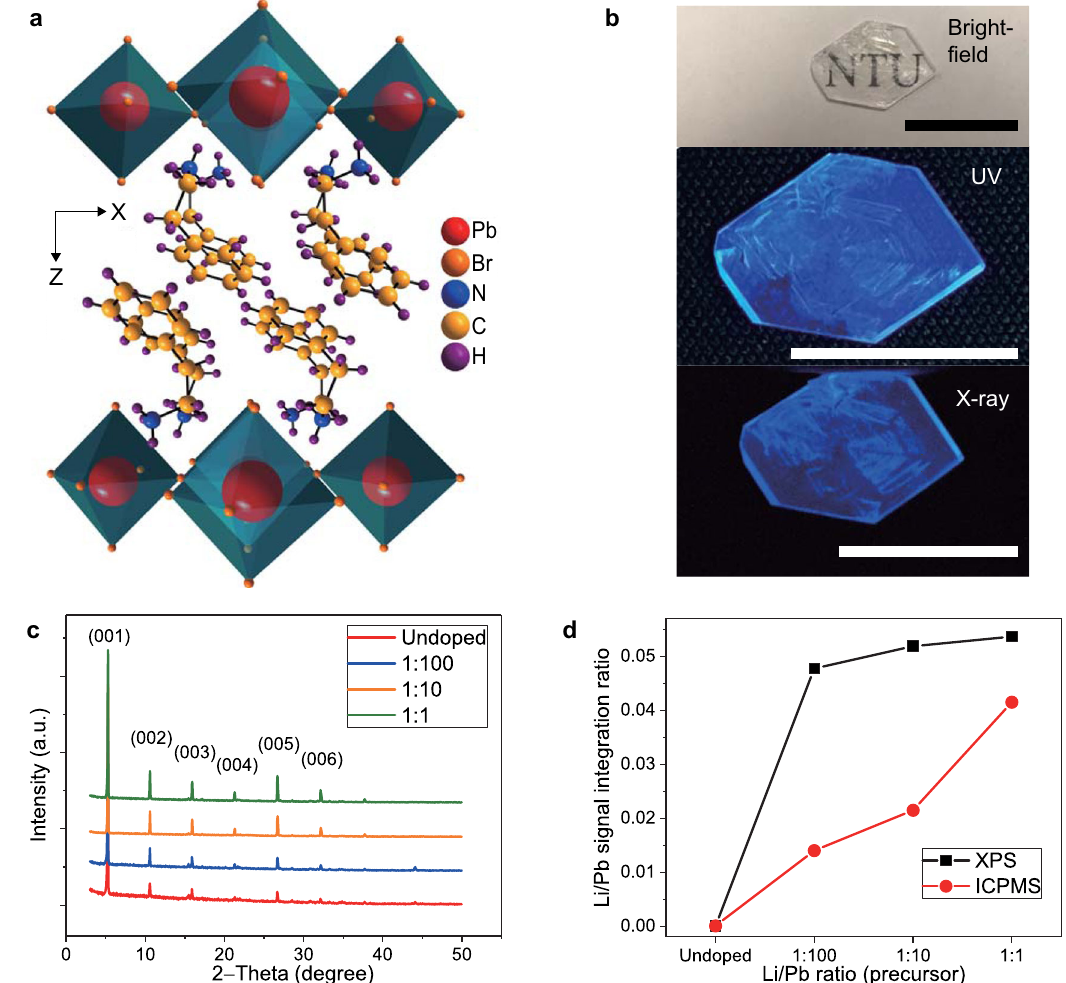
Fig. 1 Crystals structure, luminescence, and Li-dopant concentration characterization. a Crystal structure of (PEA) 2 PbBr 4 58,59 . b Bright- fi eld, UV and X- ray images of 1:1 Li-(PEA) 2 PbBr 4 single crystal. The lengths of black and white bars are 1 cm. c Powder XRD pattern of four different Li-doped crystals. d Li to Pb XPS and ICPMS signal ratios as a function of precursor